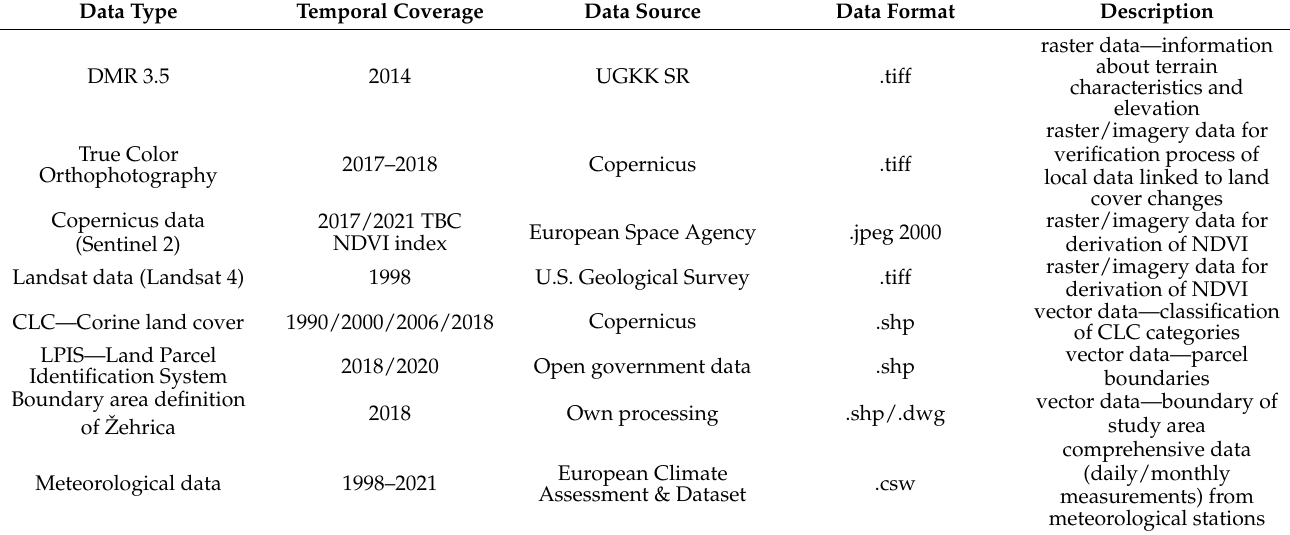
Table 2. List of used